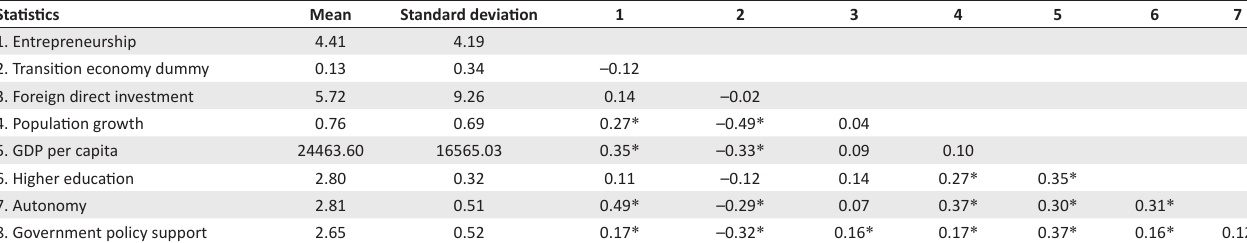
TABLE 1: Descriptive statistics and correlations. Statistics